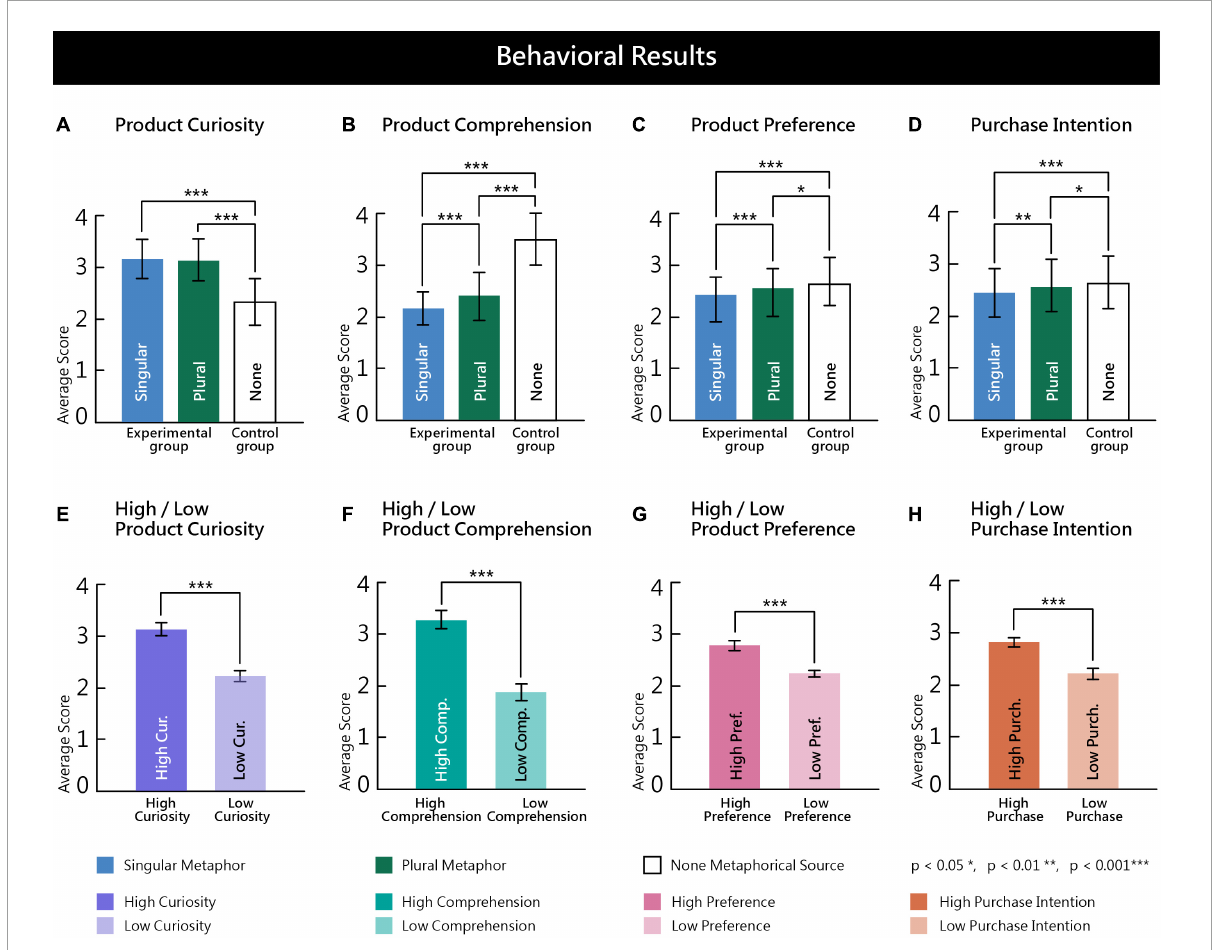
FIGURE2 (A–D) The different number of metaphorical sources (independent variable) led to significant differences in product curiosity, comprehension, preference, and purchase intention (dependent variables) ( p < 0.05). The product curiosity of the experimental groups was higher than that of the control group, whereas the product preference, comprehension, and purchase intention of the control group were higher than those of the experimental groups, while those of plural metaphorical sources were higher than those of singular metaphorical source. (E–H)